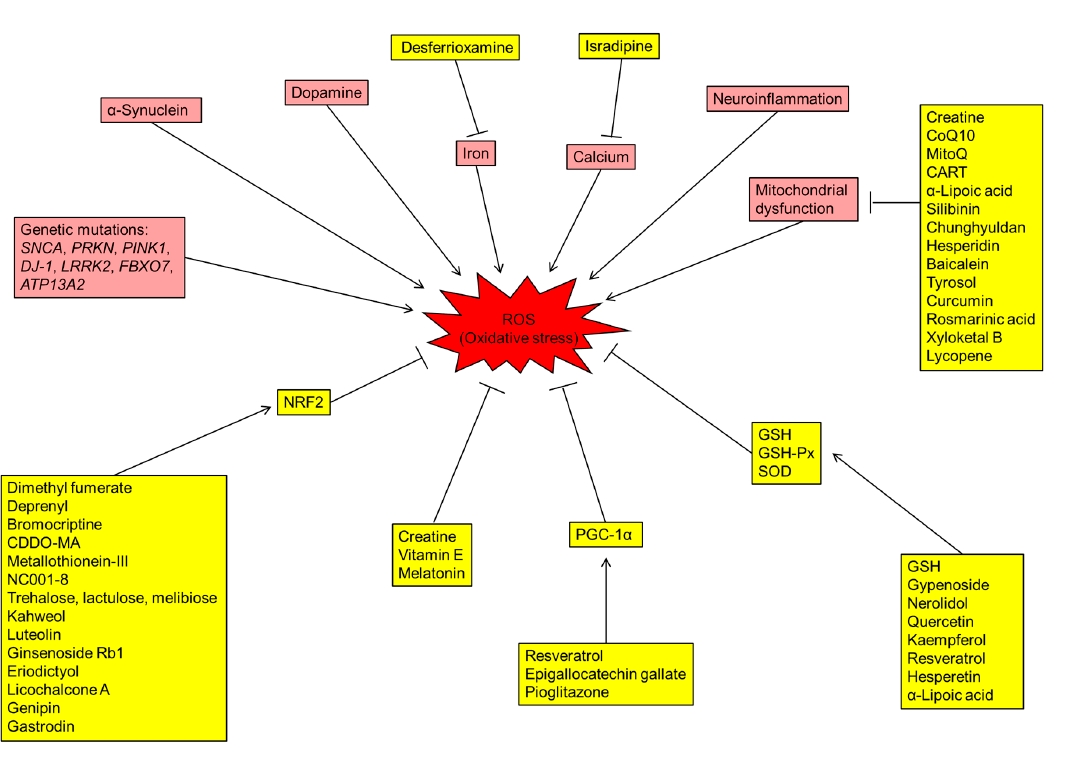
Figure 1. Schematic diagram representing the mechanisms of reactive oxygen species (ROS) production, antioxidative stress pathways and potential drugs with di ff erent targets for Parkinson’s disease (PD). Boxes shaded in red are indicative of genetic and environmental factors involved in the production of ROS. The drugs / proteins with potential in treating PD by reducing oxidative stress are indicated in boxes shaded in yellow. CoQ10: coenzyme Q10; CART: cocaine- and amphetamine-regulated transcript; GSH: glutathione; GSH-Px: glutathione peroxidase; NRF2: nuclear factor erythroid-2-related factor 2; PGC-1 α : PPAR γ coactivator-1 α ; ROS: radical oxidative species; SOD: superoxide dismutase.